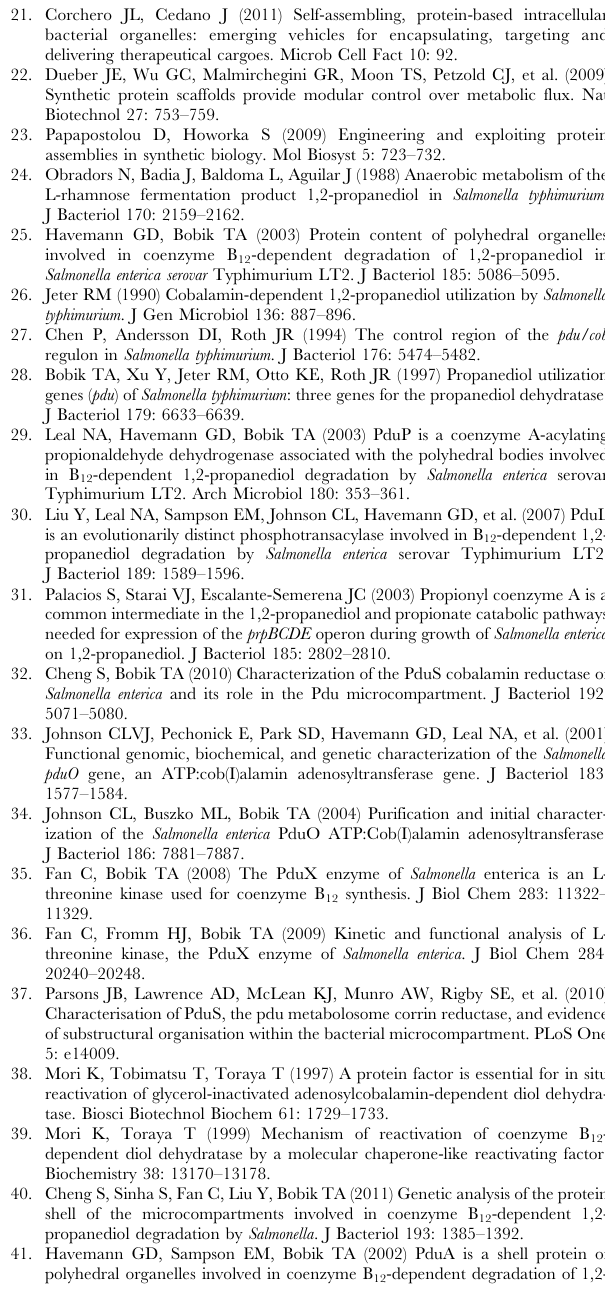
Figure S4 Identification of Fe in purified PduQ-His 6 using ICP- MS (cps: counts per second). Figure S5 Electron microscopy of wild-type Salmonella enterica and a pduQ deletion mutant. Triangles point to microcompart- ments. A number of sections were examined and the cells shown are representative. Figure S6 Electron microscopy of MCPs purified from wild-type Salmonella enterica and a pduQ deletion mutant. The image shown is a representative negative